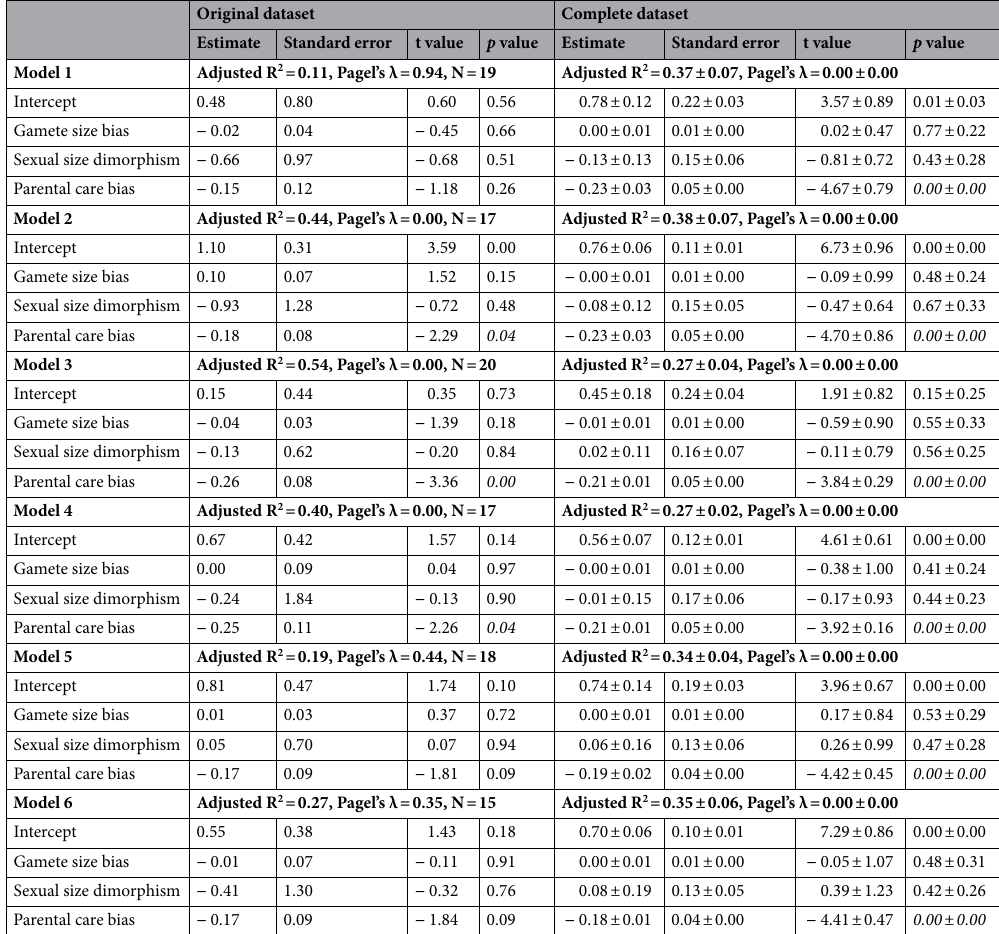
Table 2. Phylogenetically corrected multiple predictor relationships (PGLSs) between the bias of sexual selection and the bias of parental care, gametic investment and sexual size dimorphism, using the original and the completed datasets. For each model the response variables are in bold and the predictor variables are listed below. ΔI, ΔI s and Δβ ss refer to the opportunity for selection, the opportunity for sexual selection and the Bateman gradient, respectively. The response variable is ΔI (Models 1 & 2), ΔI s (Models 3 & 4), and Δβ ss (Models 5 & 6). Parental care bias was only calculated for species that exhibit some level of care, thus the models of complete dataset used 37 species. Statistically significant results are in italic. See Table 1 for further